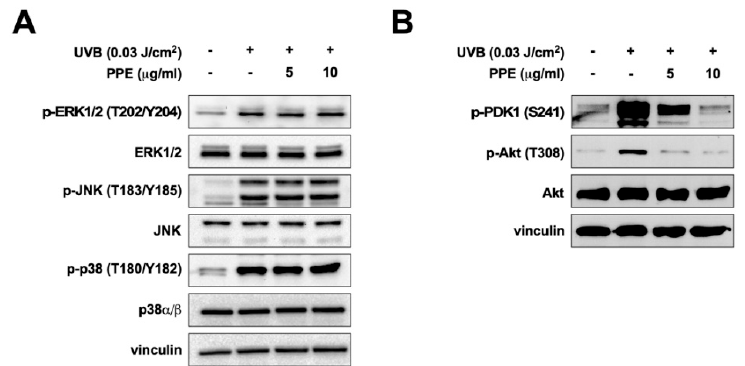
Figure 3. Effect of propolis extract on UV-induced signaling pathway in human dermal fibroblasts. Hs68 cells were pre-treated with propolis extracts (PPE) for 1 h before UVB stimulation (0.03 J/cm 2 ). Immunoblot analysis of phosphorylated and total ( A ) extracellular signal-regulated kinase (ERK), c-jun N -terminal kinase (JNK), and p38; ( B ) phosphoinositide-dependent protein kinase-1 (PDK1) and protein kinase B (Akt) expression in cell lysates. Vinculin was used as a loading